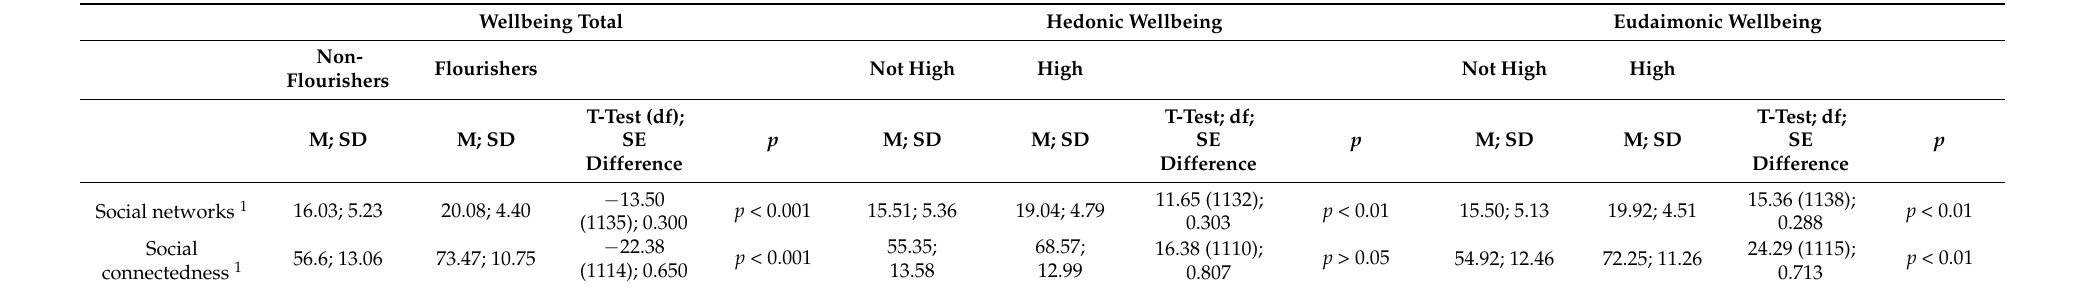
Table 3. Descriptive statistics and univariate analysis of wellbeing queried by social